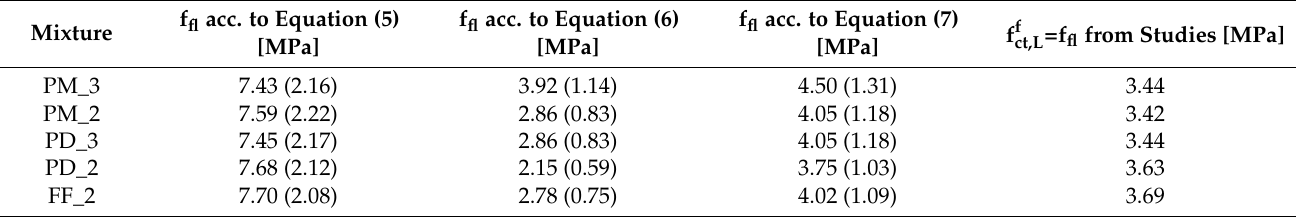
Table 9. The flexural tensile strength of FRC calculated using empirical formulas and resulting from the tests carried out. f fl acc. to Equation (5) Mixture